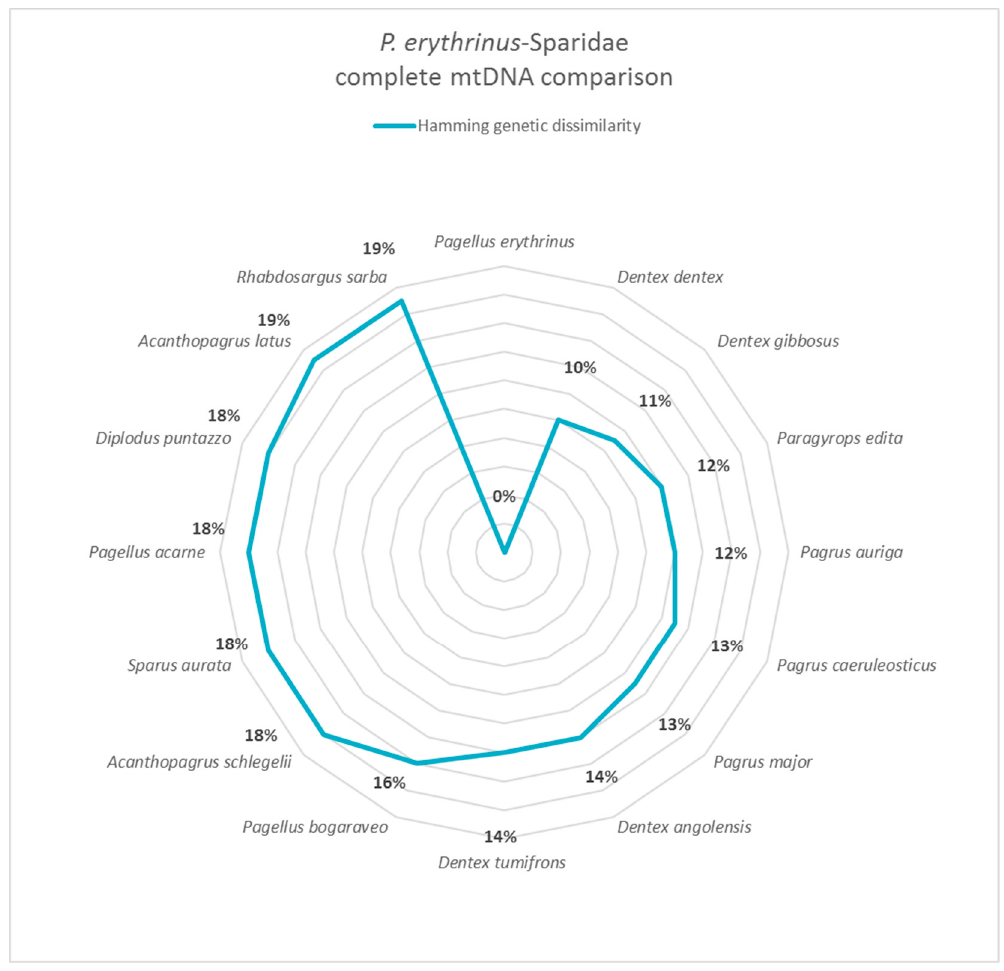
Figure 2. Hamming distance comparison showed that the genetic dissimilarity among mtDNA of Pagellus erythrinus and other sparid species ranges from 10% ( Dentex dentex) to 19% ( Acanthopagrus latus and Rhabdosargus sarba ).